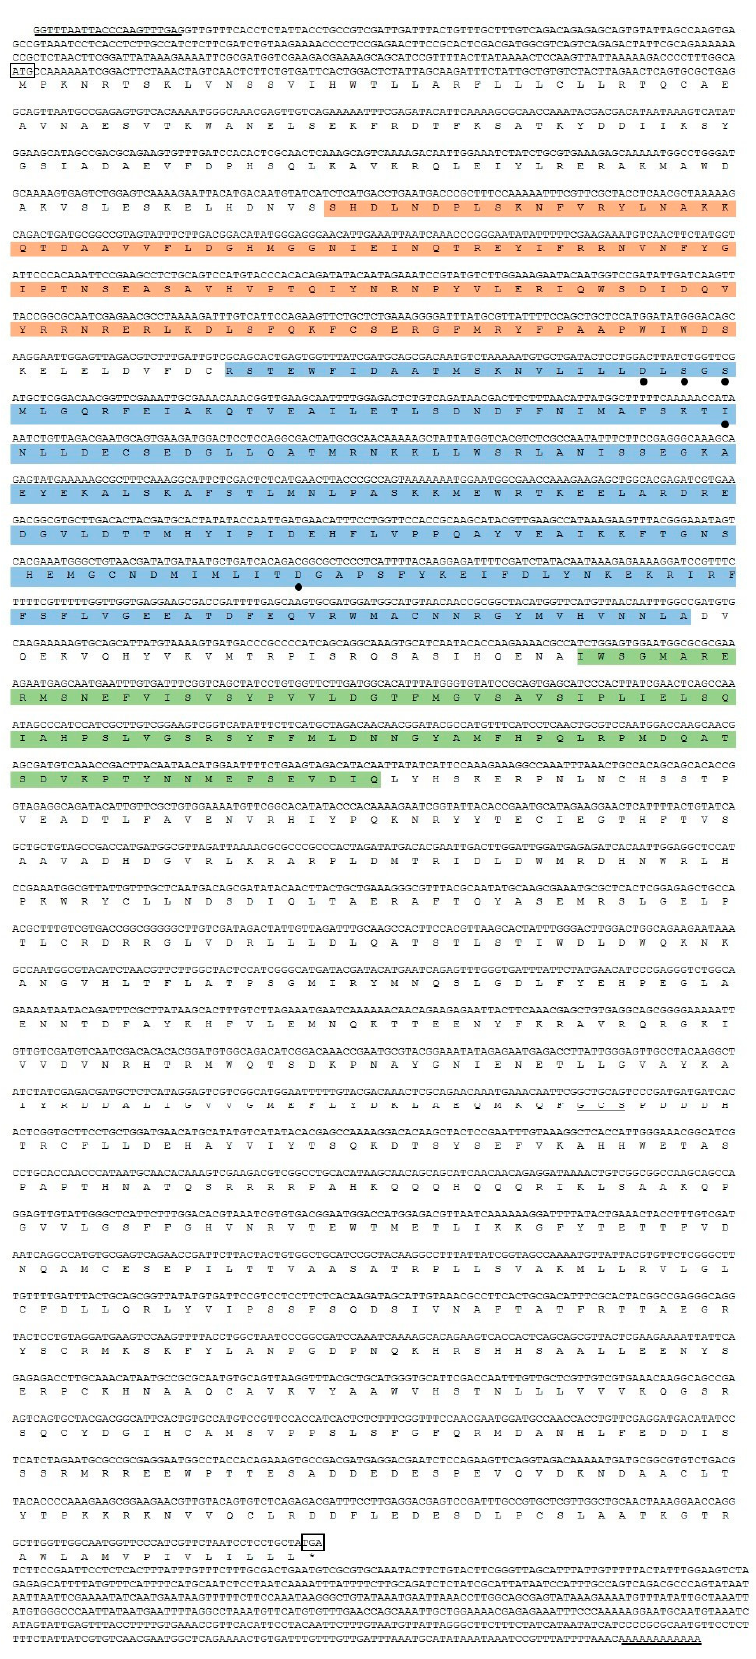
Figure 1. Sequence of DdCa v α 2 δ cDNA and its deduced amino acid sequence. The start codon (ATG) and the stop codon (TGA) are indicated by boxes. The nucleic acid sequence fragment before the